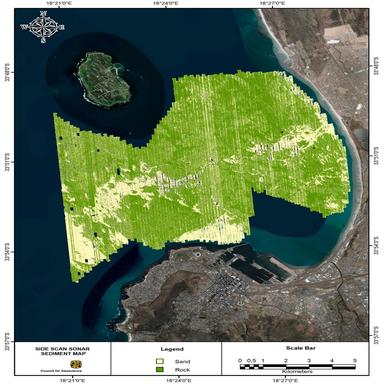
Side scan sonar classification of sediment classes showing the distribution of sand versus rock within Table Bay, as well as preserved features such as channels.